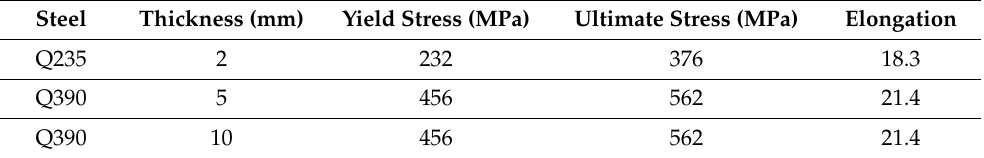
Table 2. Material properties of